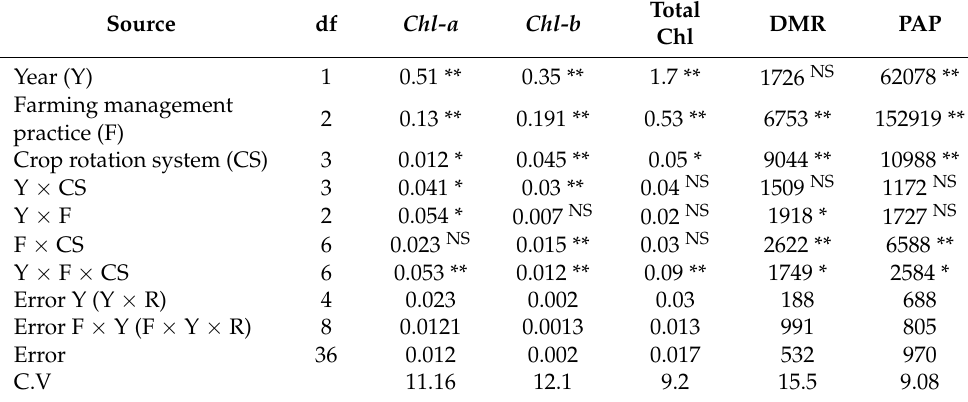
Table 2. Effects of year (Y), farm management practice (F), crop rotation system (CS), and their interactions on chlorophyll-a, chlorophyll-b, total chlorophyll, dry matter remobilisation (DMR), and